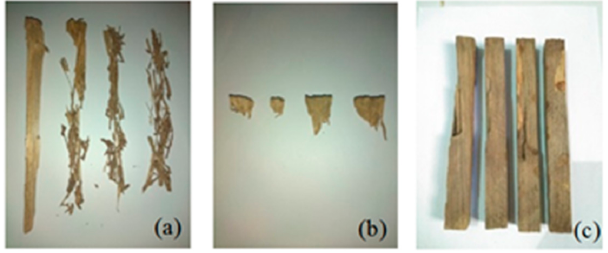
Figure 6. Condition of stakes after being attacked by subterranean termites ( a ) Coptotermes gestroi , ( b ) Schedorhinotermes sp., and ( c ) Microcerotermes serrula .